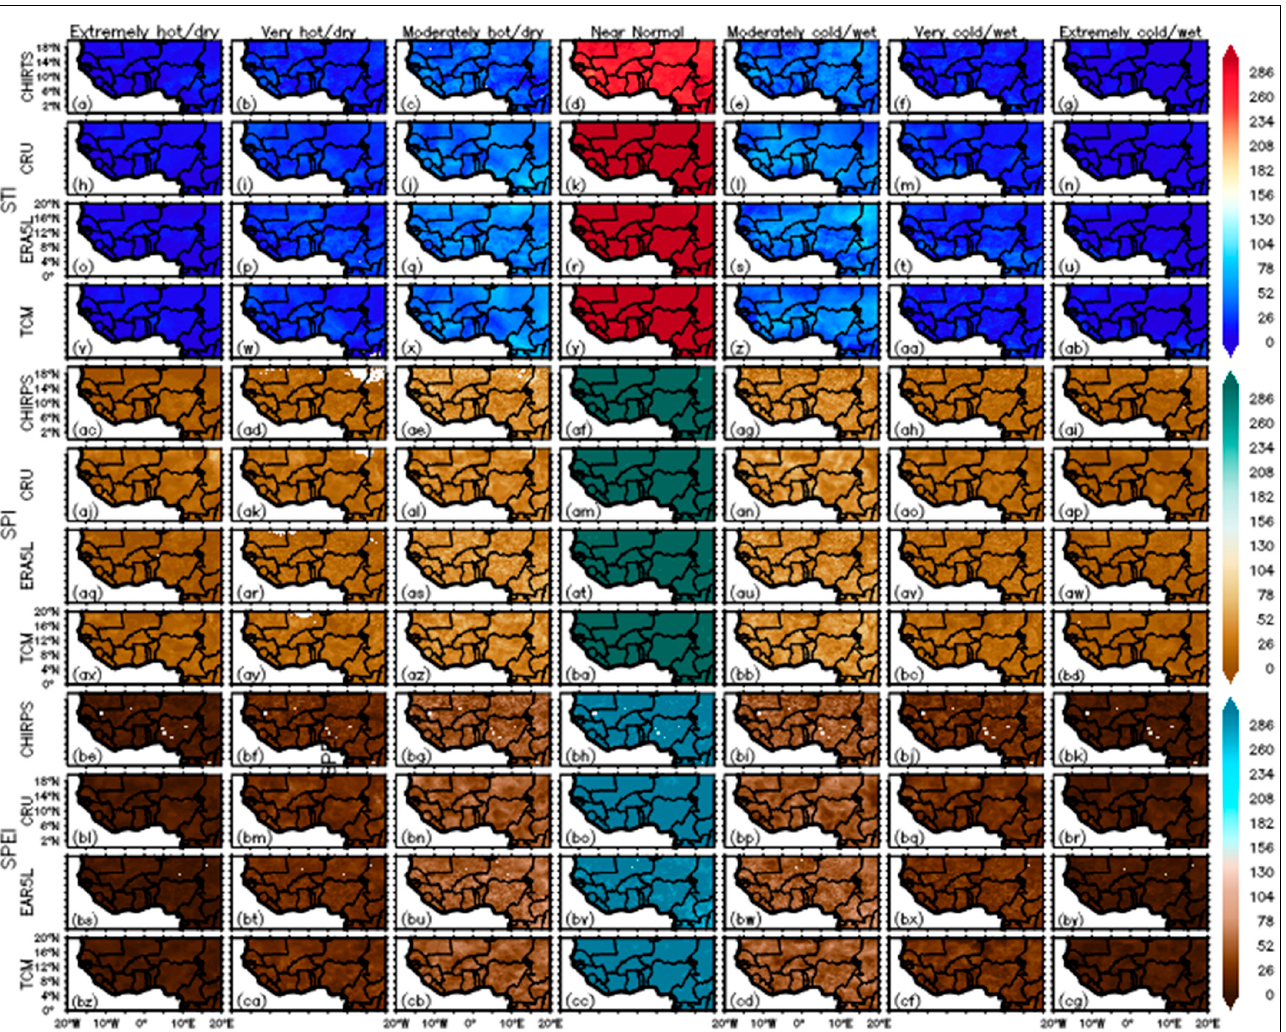
Figure 12. ( a – cg ) Occurrence frequency of various climatic conditions in West Africa.